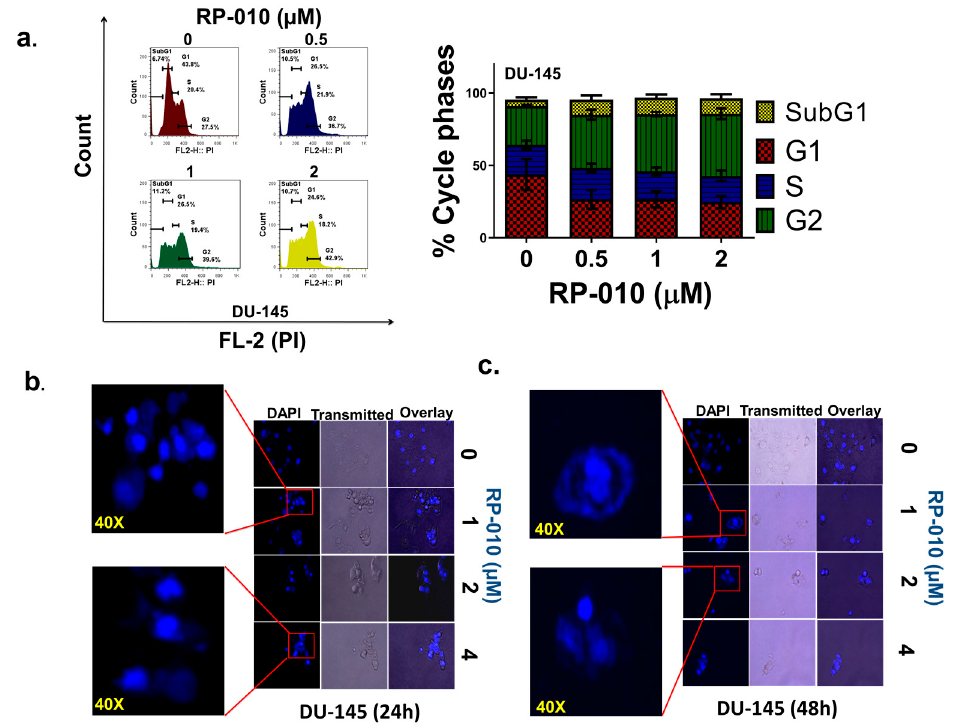
Figure 2. The changes induced by RP-010 on the cell cycle and nuclear events. ( a ) Analysis of RP-010 (0, 0.5, 1, or 2 µM)-induced changes on the cell cycle, using a flow cytometry assay (propidium iodide, “PI,” on the ordinate, and cell count on the abcissa). A graph showing the percent change for each phase, following incubation with RP-010, is shown on the right. In ( b ) and ( c ) the effects of RP-010 (1, 2 or 4 µM) and vehicle on events in the nuclei of DU145 cells, at 24 and 48 h, respectively, are shown. Both chromatin condensation and mitotic catastrophe can be seen.